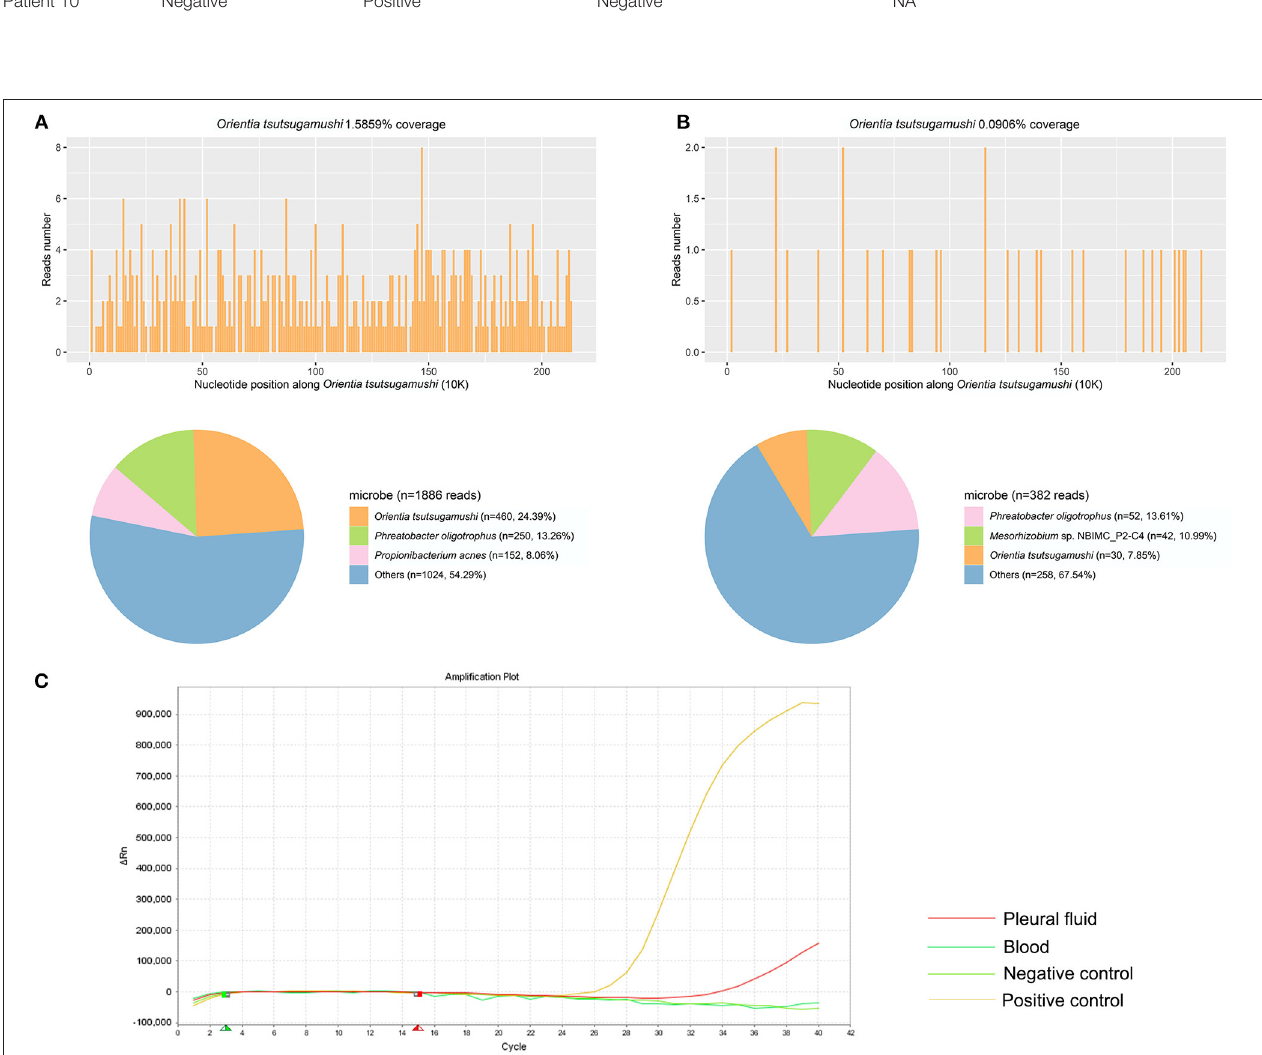
FIGURE 1 | The results of metagenomic next-generation sequencing (mNGS) and qPCR in patient 8 using pleural fluid and blood. (A) A total of 460 unique reads of Orientia tsutsugamushi were detected by mNGS using pleural fluid. (B) A total of 30 unique reads of O. tsutsugamushi were detected by mNGS using blood. (C) qPCR of O. tsutsugamushi showed positive in pleural fluid but negative in blood.